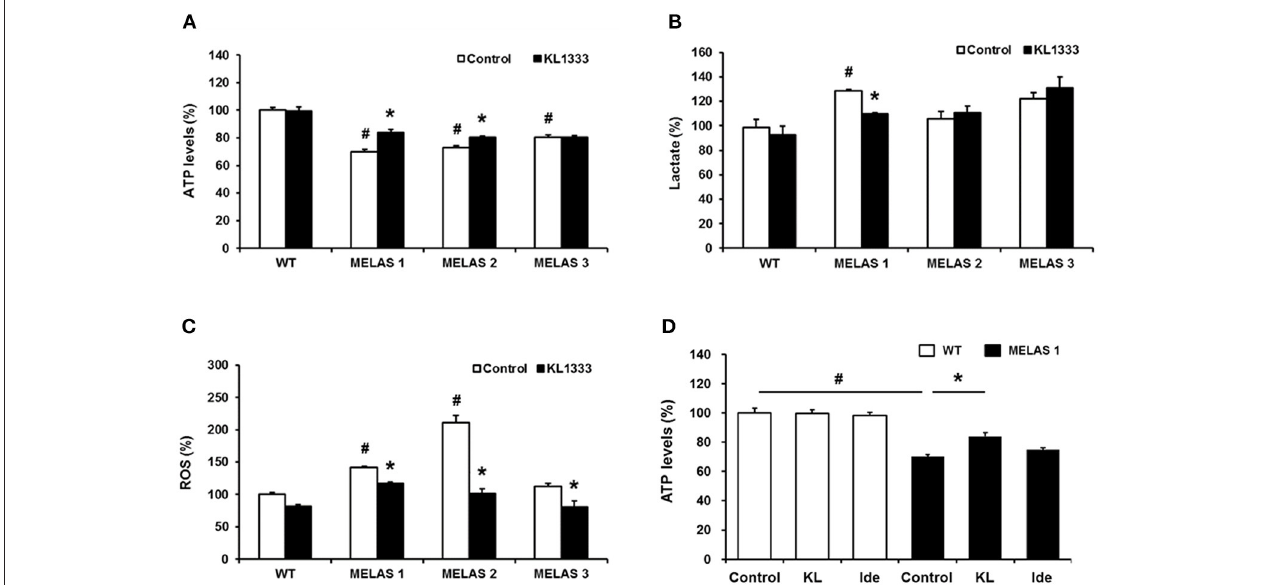
FIGURE 5 | KL1333 regulates intracellular ATP, lactate, and ROS levels in MELAS fibroblasts. Human fibroblasts derived from three patients with MELAS were treated with 1 µ M KL1333 for 24h. (A) Cells were lysed in extraction buffer, and intracellular ATP levels were measured. (B) Cell lysates were reacted with enzyme mixtures, and intracellular lactate levels were measured. (C) Cells were stained with CM-H2DCFDA, and ROS levels were measured using a flow cytometer. (D) MELAS 1 fibroblasts were treated with 1 µ M KL1333 (KL) or 1 µ M idebenone (Ide) for 24h. Cell lysates were used for measurement of ATP levels. Each experiment was repeated three times. Error bars indicate ± SEM. # P < 0.05: MELAS fibroblast vs. WT control. * P < 0.05: presence versus absence of KL1333.